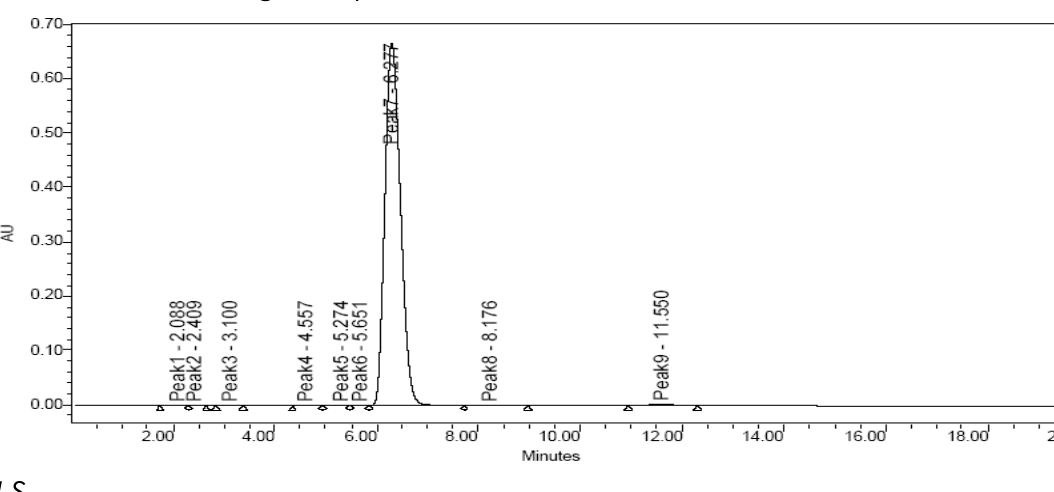
Figure 7. The molecular mass of the phlorhizin dihydrate standard is 472 Da, and the expected [ M − H] − negative ion was observed in the spectra at m/z 471. Loss of two H O − H] − ion at m/z 435. Cleavage of a glucose fragment without a OH substituent gave a [ M − 2H 2